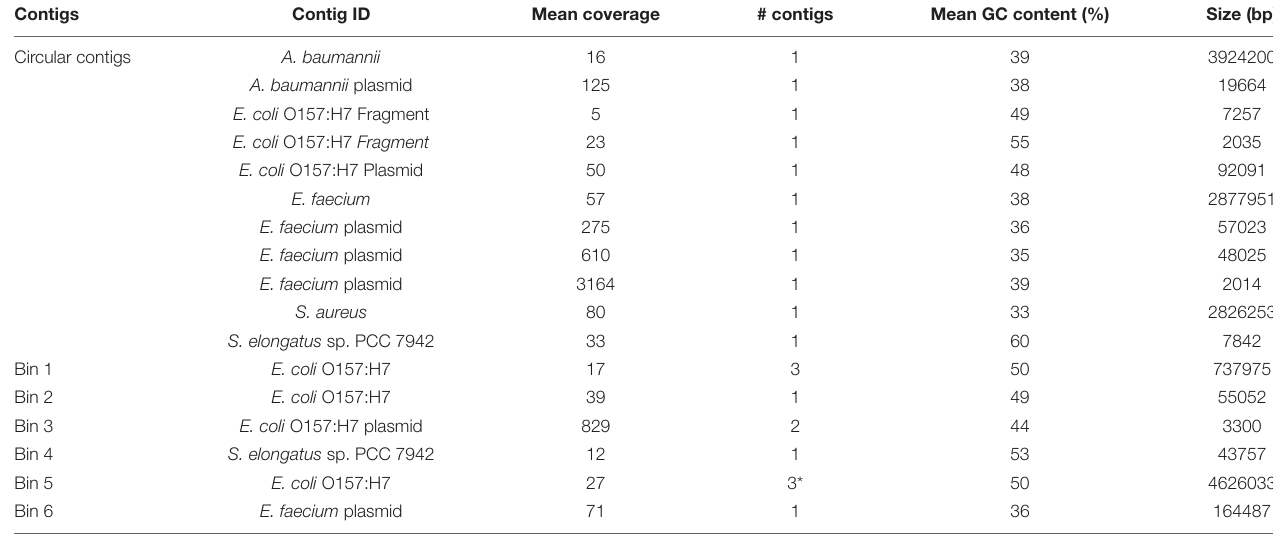
TABLE 6 | Assembly statistics for the MinION mock metagenome assembly. Contigs Contig ID Mean coverage # contigs Mean GC content (%) Size (bp) Circular